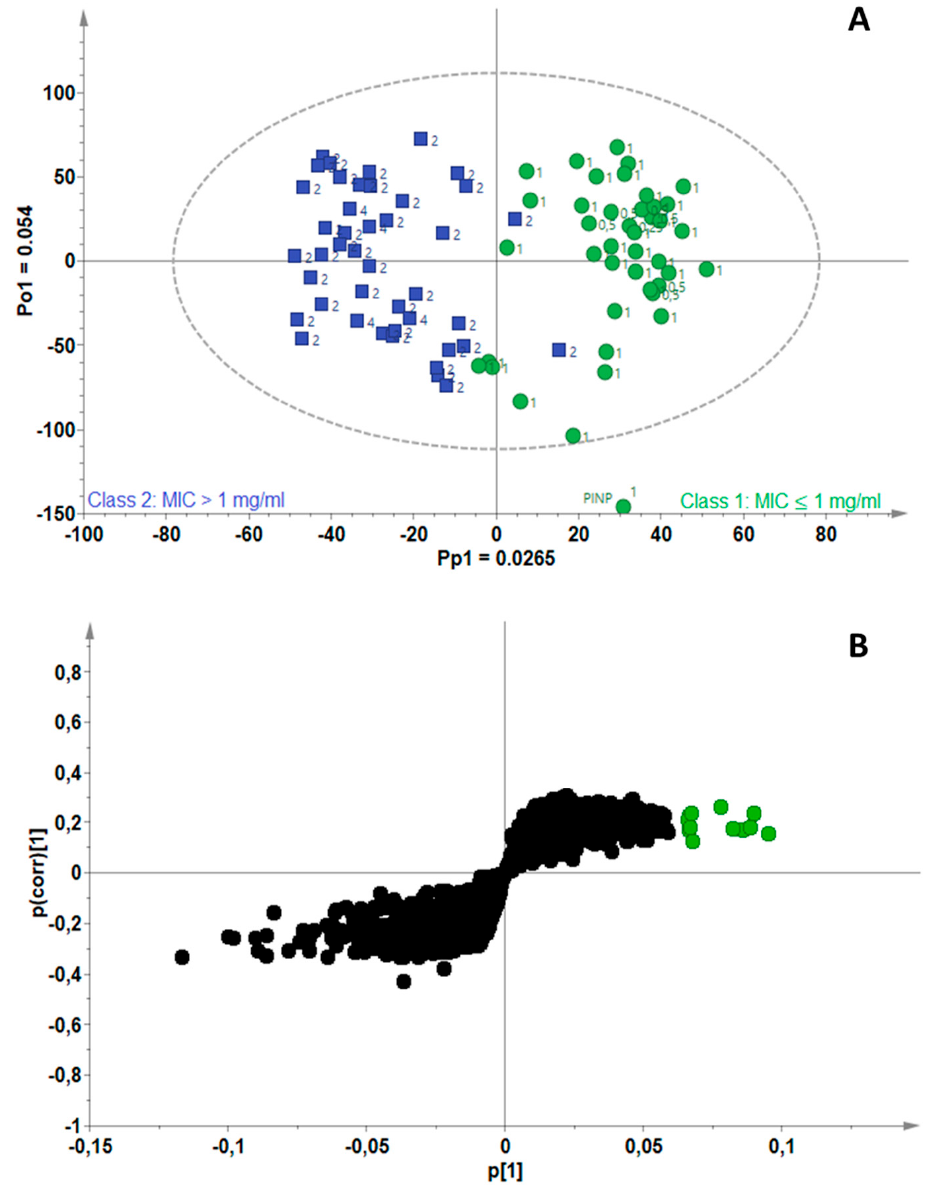
Figure 3. ( A ) OPLS-DA scores scatterplot for Mycobacterium fortuitum, showing separation of active (green) and non-active (blue) essential oils, ( B ) S-plot of the variables, indicating the putative biomarkers (green) associated with essential oils active against M. fortuitum.